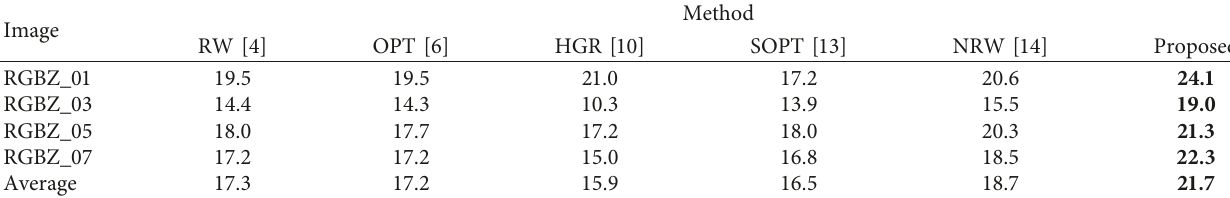
Table 4: PSNR comparison in the presence of inaccurate scribbles.